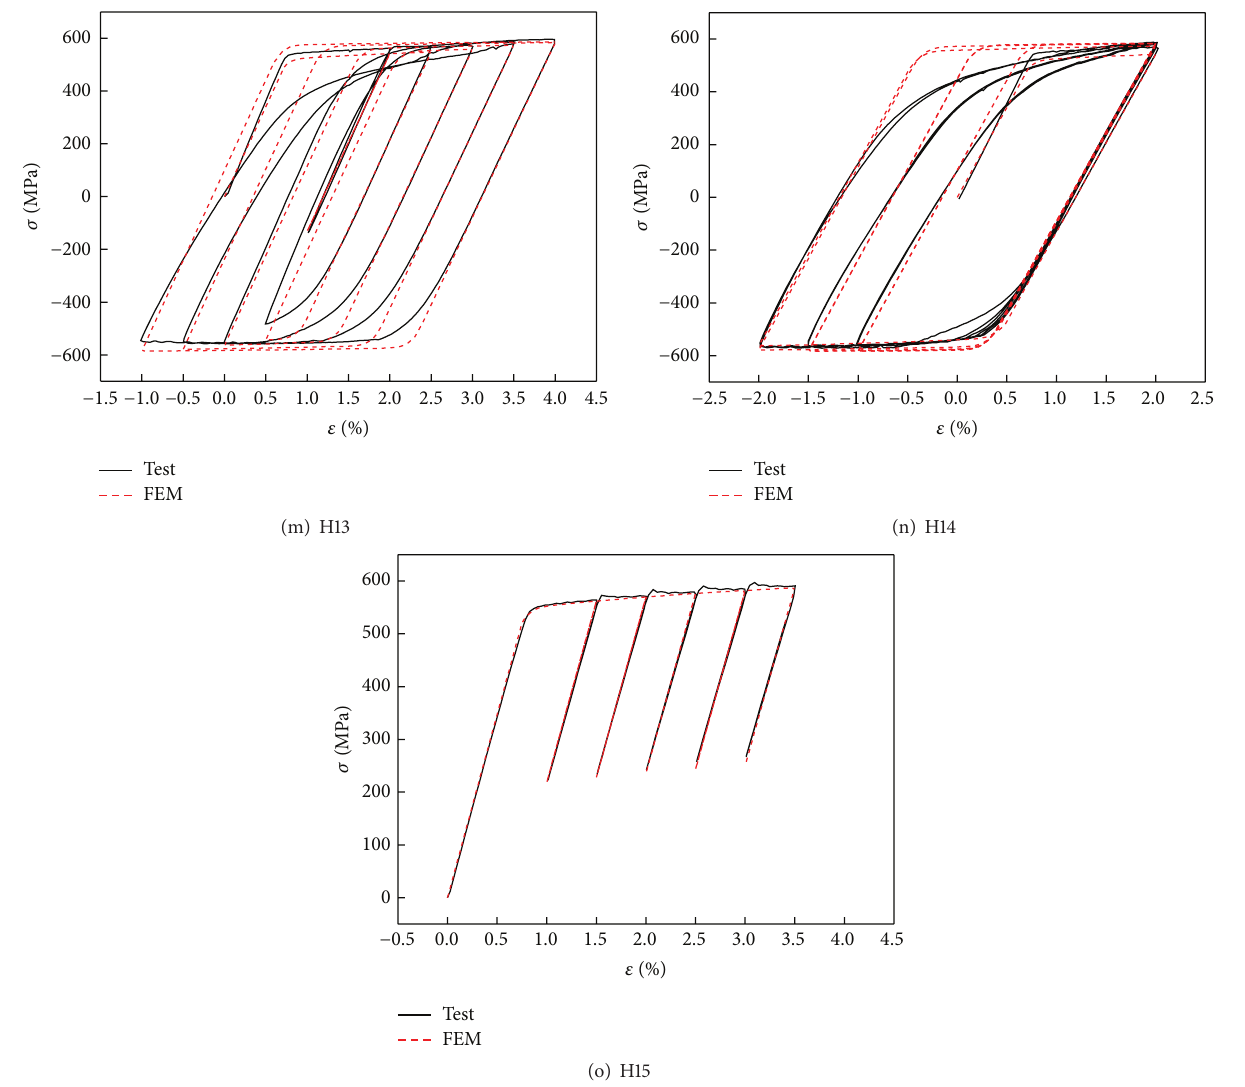
Figure 12: Comparison analysis between test curves and FE